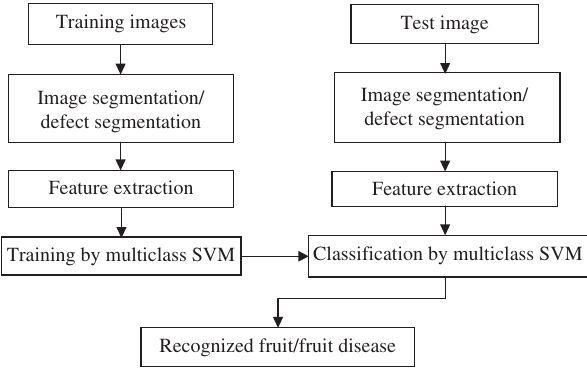
Figure 1. Fruit and Fruit Disease Recognition System [17, 18].